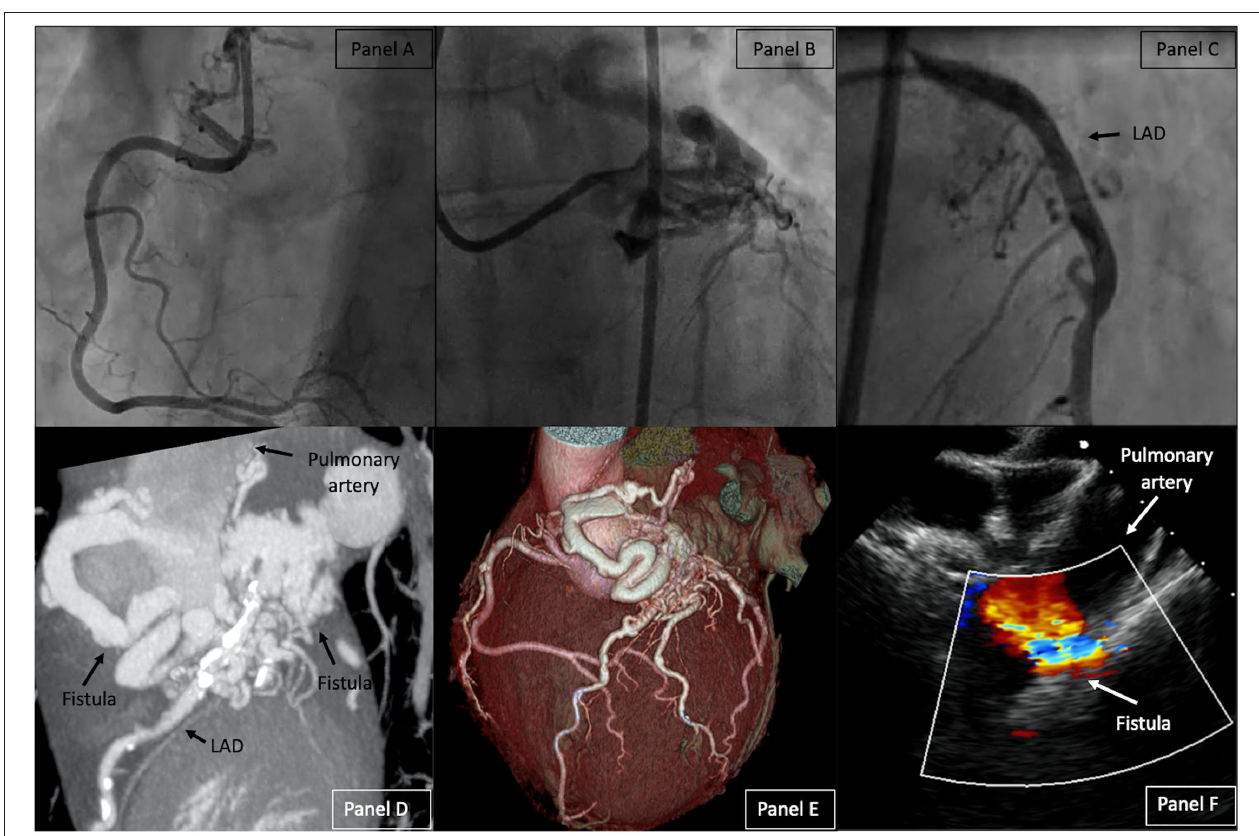
FIGURE 1 | Right Coronary Artery (RCA) with the right part of the fistula (A) , Left Coronary Artery (LCA) with the left part of the fistula (B) , Selective LAD injection (C) . Baseline CCT with 2D Maximum intensity projection of the fistula (D) and 3D volume rendering of the heart (E) . TOE before fistula closure (F) . LAD, left anterior descending artery; CCT, cardiac CT ; TOE, transoesophageal echocardiogram